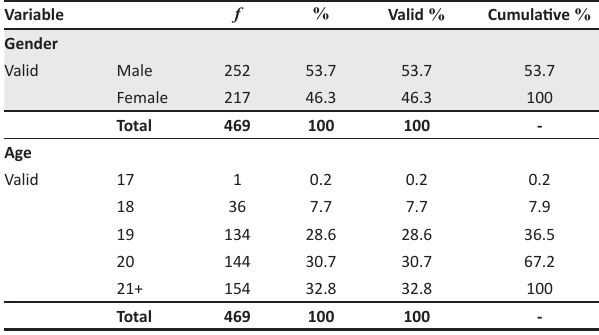
TABLE 1: Demographic profile of